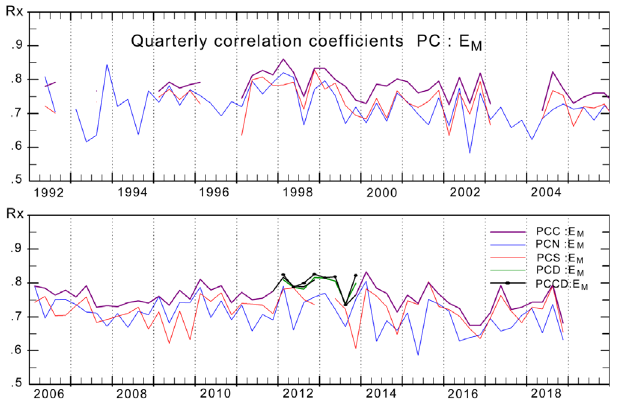
Fig. 4. Correlation of the solar wind merging electric fi eld, E M , with polar cap indices, PCN (blue line), PCS (red), PCC (magenta), PCD (green), and PCCD (black). PCD and PCCD use Dome-C magnetic data.